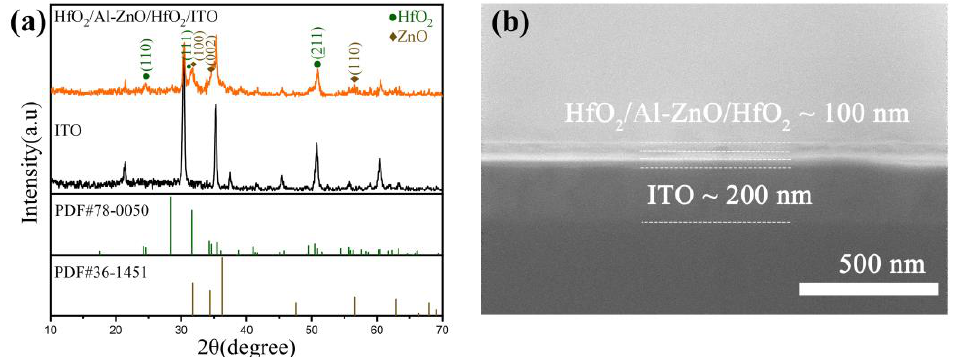
Figure 2. ( a ) XRD patterns of ITO substrate and HfO 2 /Al-ZnO/HfO 2 /ITO thin film, and ( b ) SEM image of HfO 2 /Al-ZnO/HfO 2 /ITO.